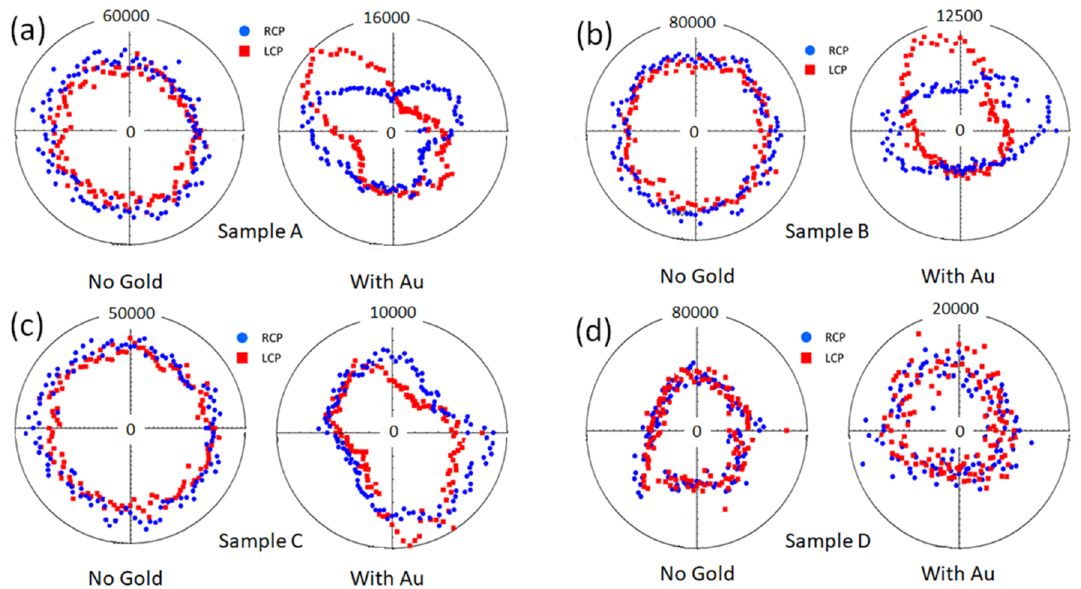
Figure 5. p-polarized SHG signal from: ( a ) Sample A; ( b ) Sample B; ( c ) Sample C; ( d ) Sample D. On the left side of each panel the samples without Au coating for RCP and LCP light are shown, while on the right side of each panel, the samples with Au coating are shown. Adapted from [26]. In the measurements the azimuthal rotation angle is